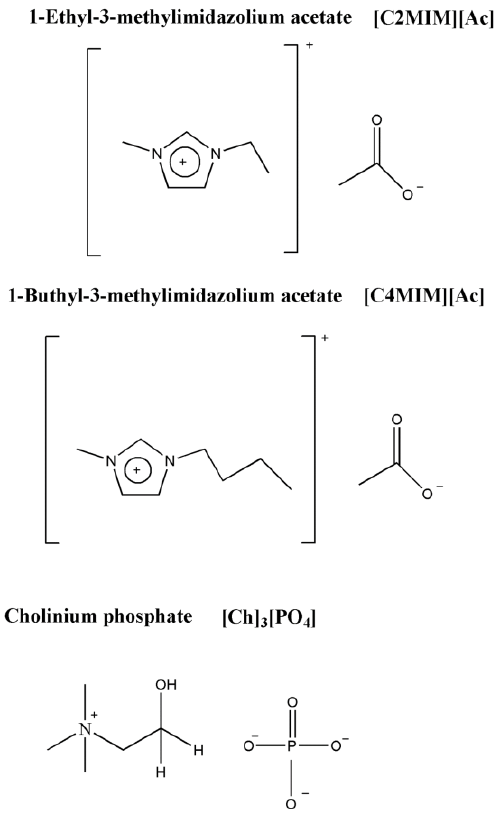
Figure 1. Chemical structures of 1-Ethyl-3-methylimidazolium acetate [C2MIM][Ac], 1-Butyl-3-methylimidazolium acetate [C4MIM][Ac] and Cholinium phosphate [Ch] 3 [PO 4 ]. The comparison of the wild-type Ideonella sakaiensis PETase structures in different solvents after 150 ns of MD simulation is shown in Figure 2, where the PETase backbone in different solvents was superimposed.